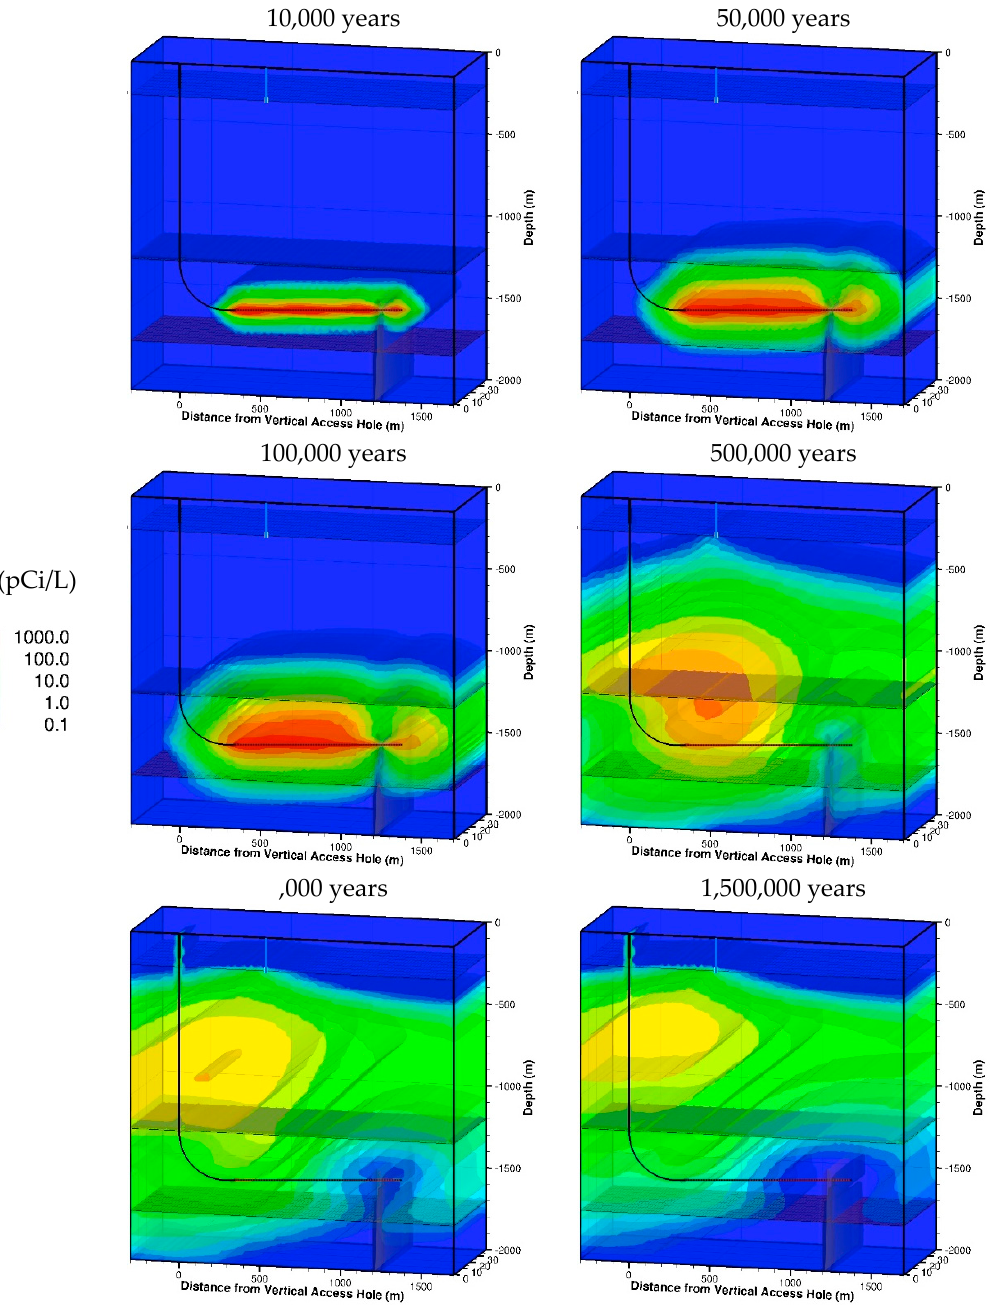
Figure 9. Distribution of 129 I activity at different times for one ‐ fault scenario with well ‐ sealing backfill.